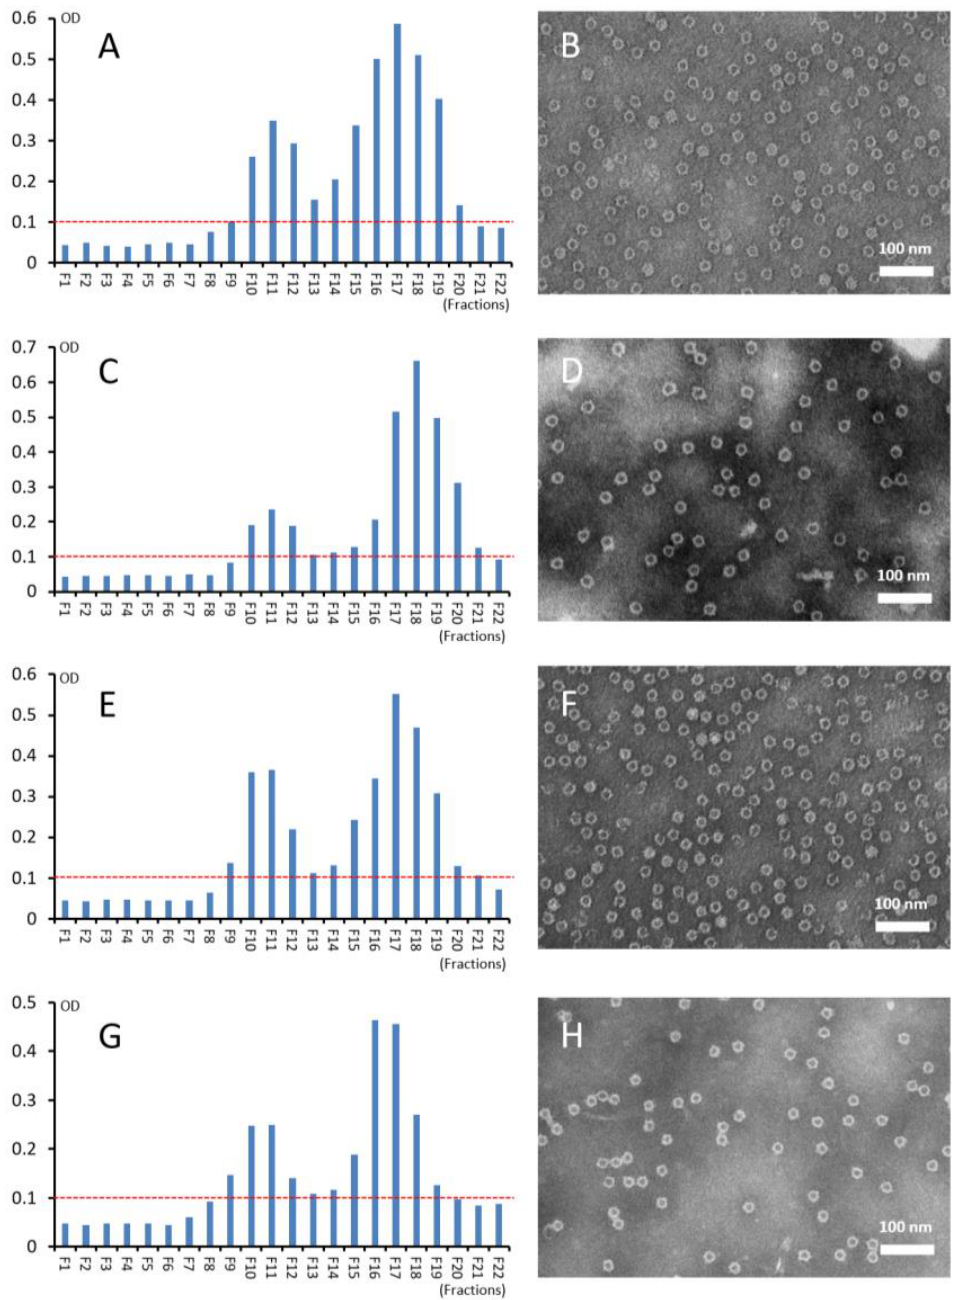
Figure 3. Analyses of the four S 60 -VP8* PVNPs using cesium chloride (CsCl) density gradient centrifugation and transmission electron microscopy (TEM). ( A , C , E , G ) Following centrifugation, the CsCl density gradients containing the S 60 -VP8* PVNPs of P[4] ( A ), P[6] ( C ), P[8] ( E ), and P[11] ( G ) rotaviruses, respectively, were fractionated into 22 portions. The relative S 60 -VP8* protein amounts in the fractions were measured by EIA assays using a hyperimmune antibody against norovirus VLP [52]. Y-axes show signal intensities in optical density (OD), with red dashed lines showing the cut-off signal at OD = 0.1, while X-axes indicate the fraction numbers. ( B , D , F , H ) Negative stain TEM micrographs of the S 60 -VP8* PVNPs from fractions 17 ( B , F , H ), or 18 (D), showing uniform, ring-shaped PVNPs containing VP8* antigens of the P[4] ( B ), P[6] ( D ), P[8] ( F ) rotaviruses, and P[11] ( H ) rotaviruses,